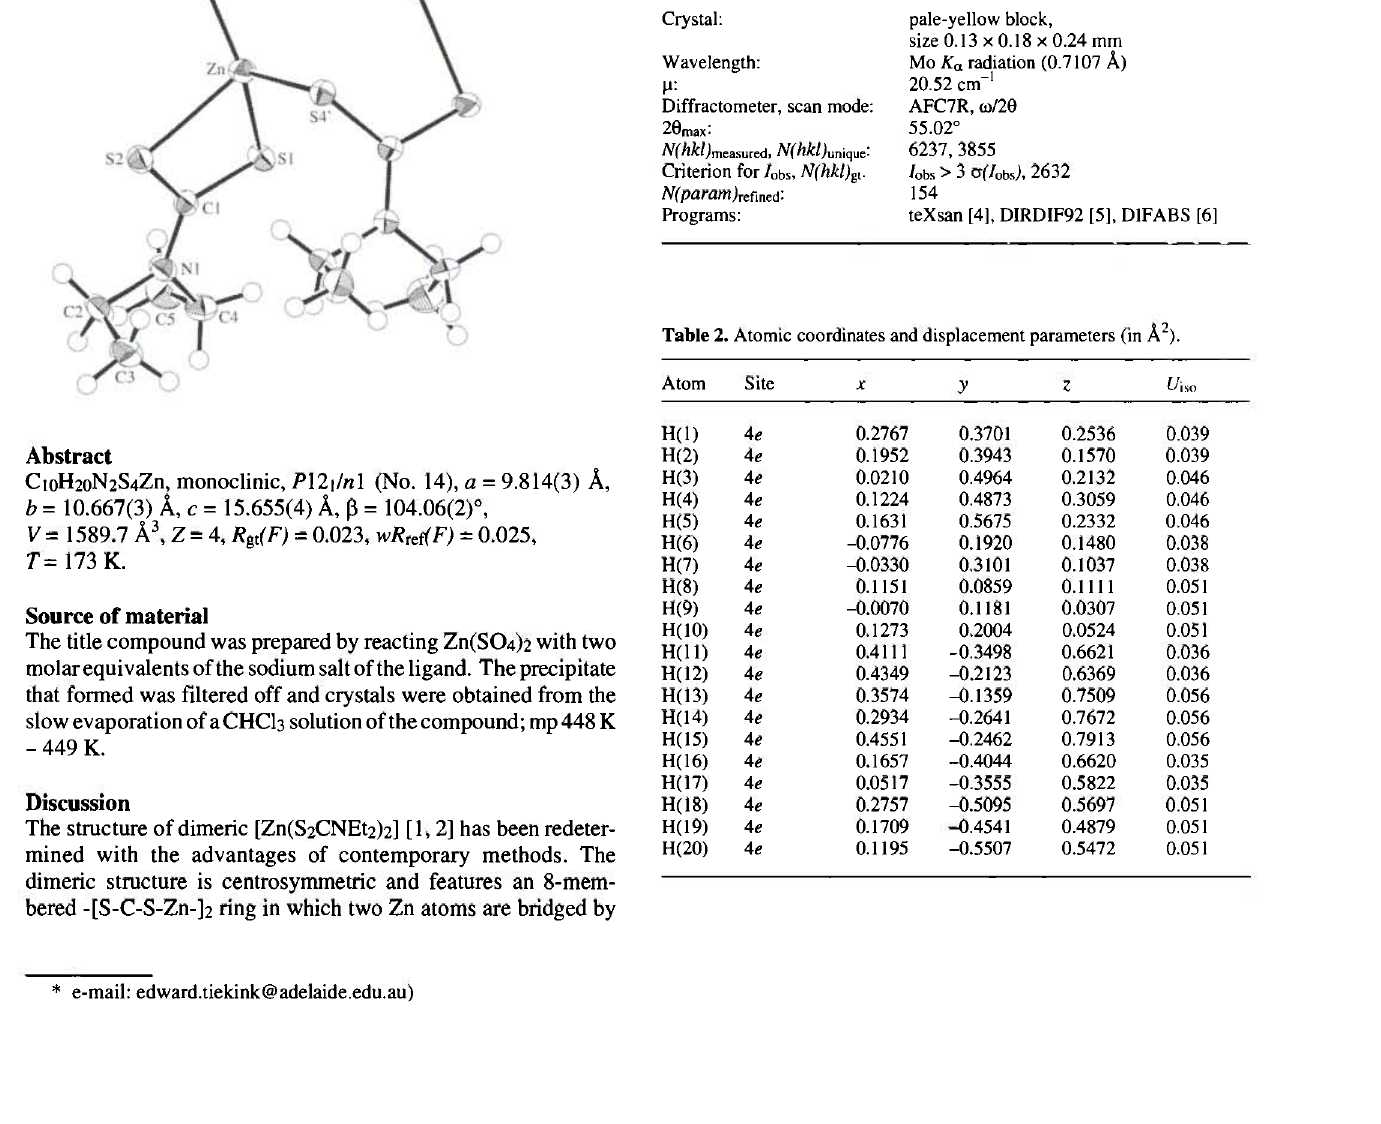
Table 2. Atomic coordinates and displacement parameters (in Ä 2